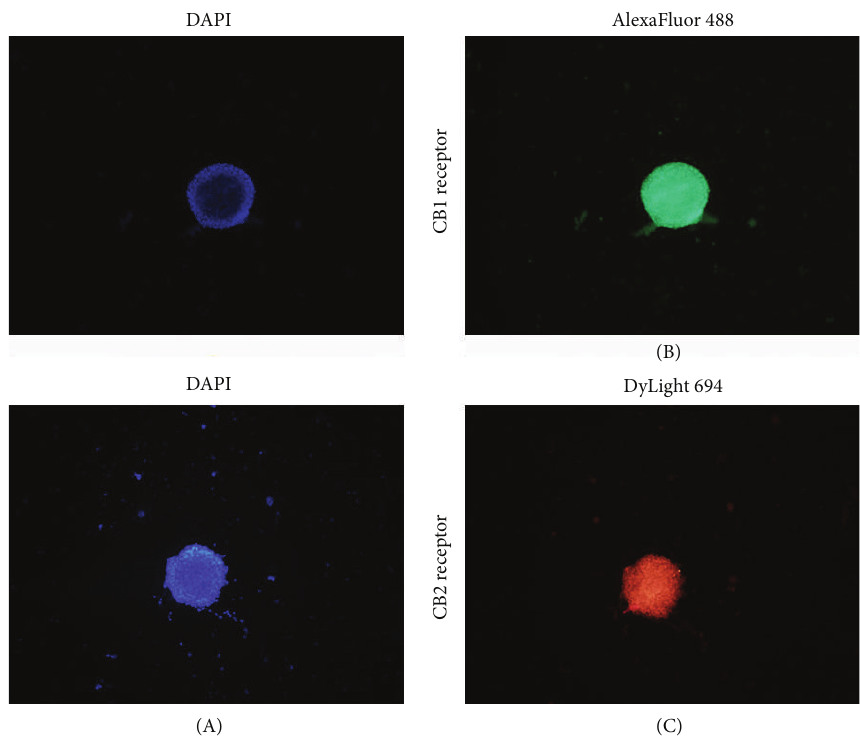
Figure 2: Detection of CB1 and CB2 receptor immunoreactivity in neurosphere. (A) Neurosphere was counterstained with DAPI (blue). (B) Neurosphere was immunolabeled with anti-CB1 antibodies and AlexaFluor 488 goat anti-rabbit immunoglobulins (green). (C) Neurosphere was immunolabeled with anti-CB2 antibodies and DyLight 694 goat anti-rabbit IgG (red) original magnification, 100x.